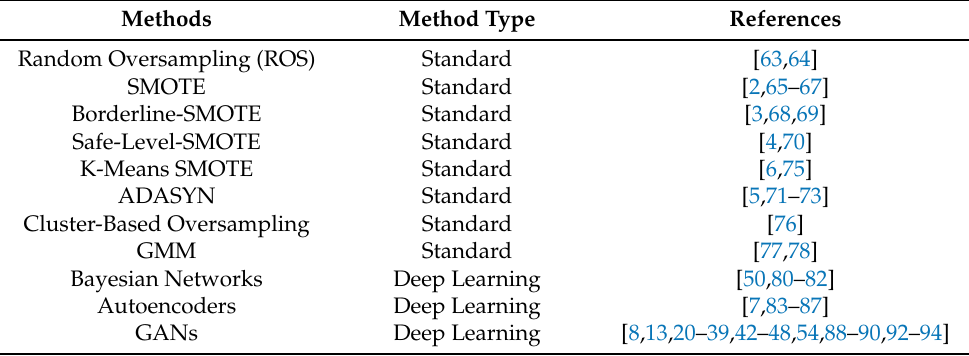
Table 4. Summary of the synthetic data generation methods covered in this